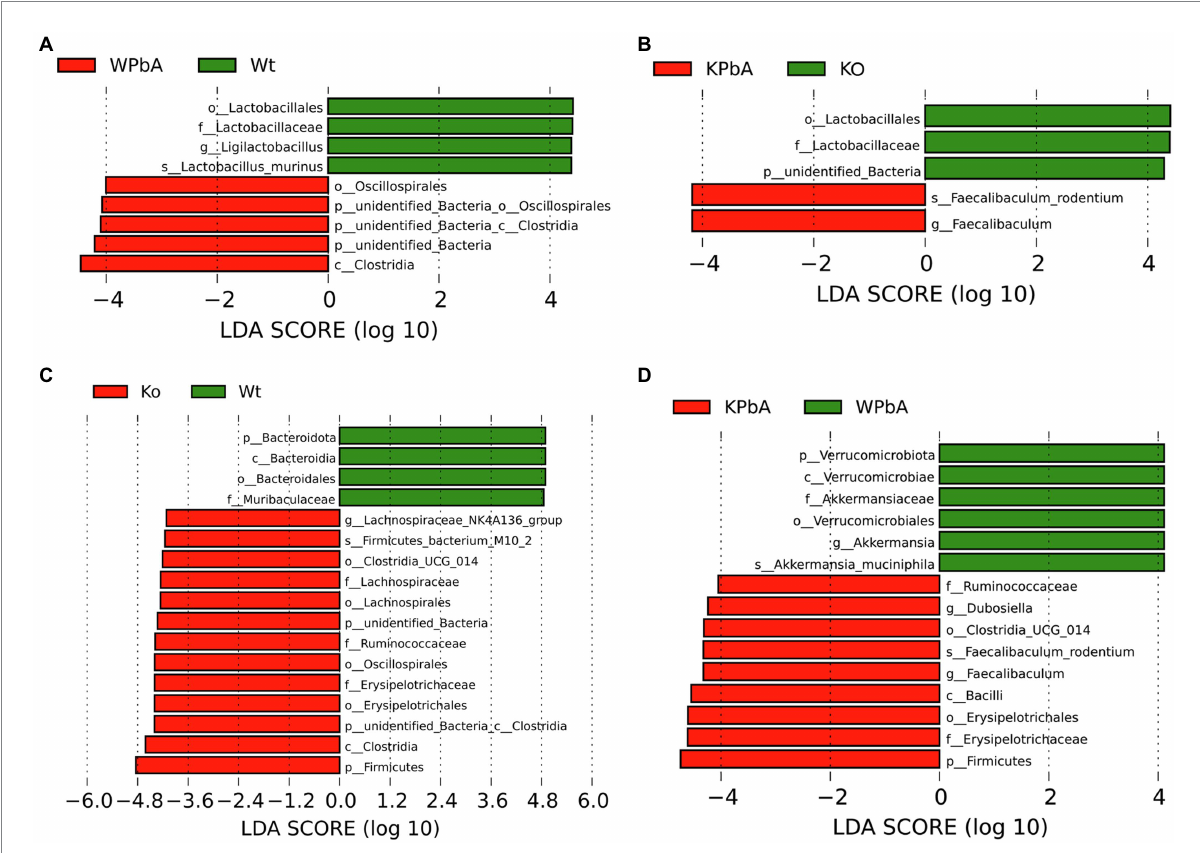
FIGURE 5 The differentially abundant bacterial taxa identified by LEfSe among different groups. (A) Linear discriminant analysis (LDA) score distribution between the WT and WPbA groups. (B) LDA score distribution between the KO and KPbA groups. (C) LDA score distribution between the WT and KO groups. (D) LDA score distribution between the WPbA and KPbA groups. The histogram of LDA value distribution only showed the species whose LDA score was greater than the default setting (threshold > 4), which represented the biomarkers with significant differences between